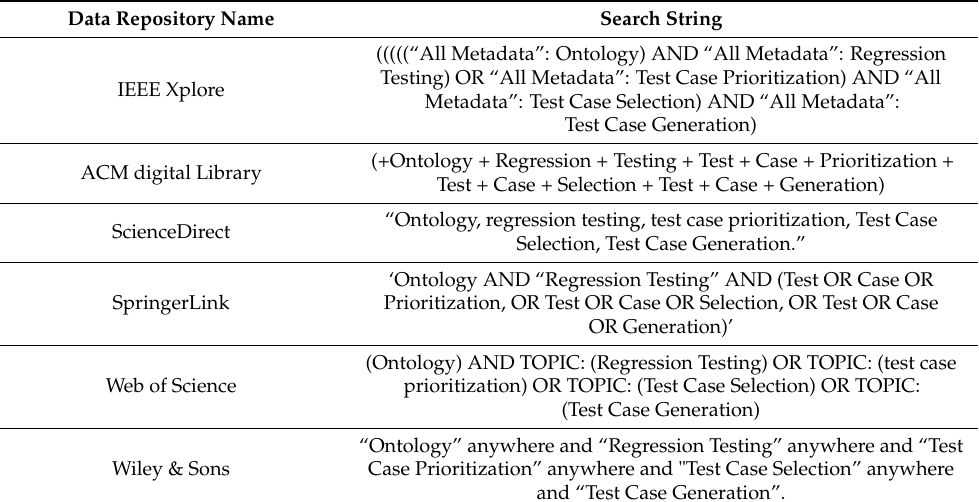
Table 3. Search strings used for paper’s